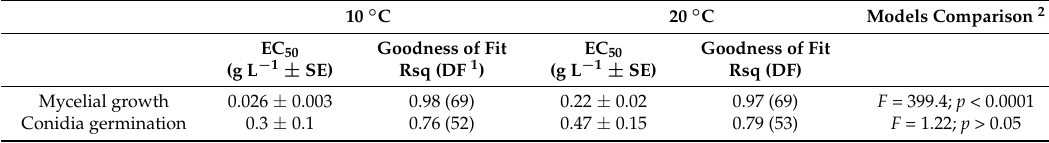
Table 2. Values of EC 50 (g L − 1 ) for the inhibition of mycelial growth and the conidia germination of F. circinatum by BioFence ® at two different temperatures (10 °C and 20 °C). No significant differences were found between the isolates, FcCa1 and Fc015; thus, the data were combined for the statistical analysis.